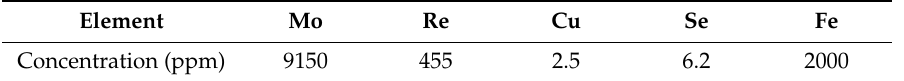
Figure 1. Dissolution of metal oxides from flue dust: ( a ) pH variations and ( b ) metal recovery over time. T = 85 °C, t = 360 min, 600 rpm. Table 3. Chemical composition of stock solution.